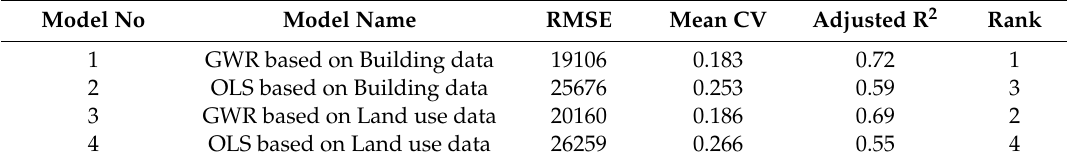
Table 2. Comparison of the accuracy of four different models based on RMSE, CV and adjusted R 2 . Model No